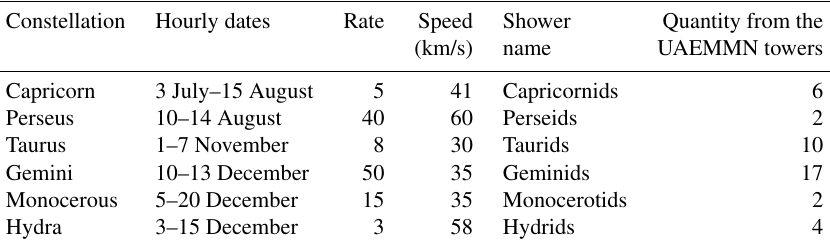
Table 2. Meteor showers observed by the UAEMMN network. Constellation Hourly dates Rate Speed Shower Quantity from the